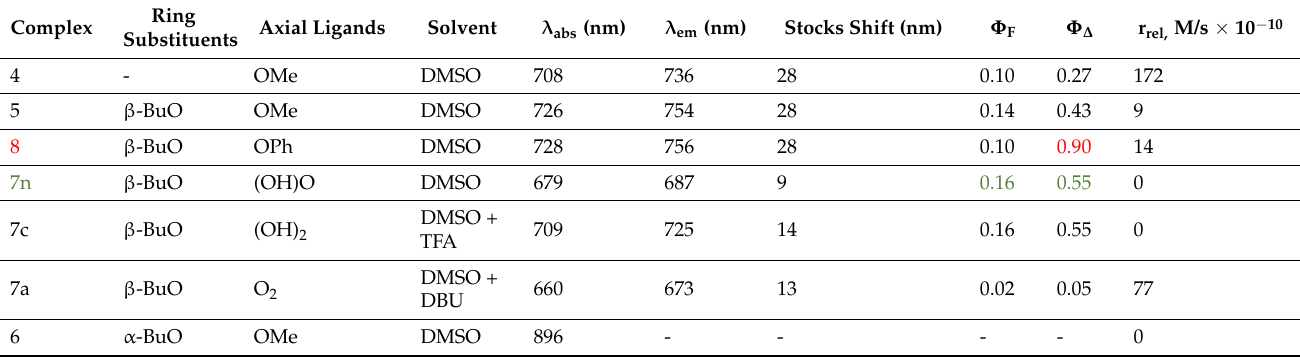
Table 1. Photophysical and photochemical data of studied compounds. Highlighted in color are the P(V)Pc complexes with the most noteworthy properties.